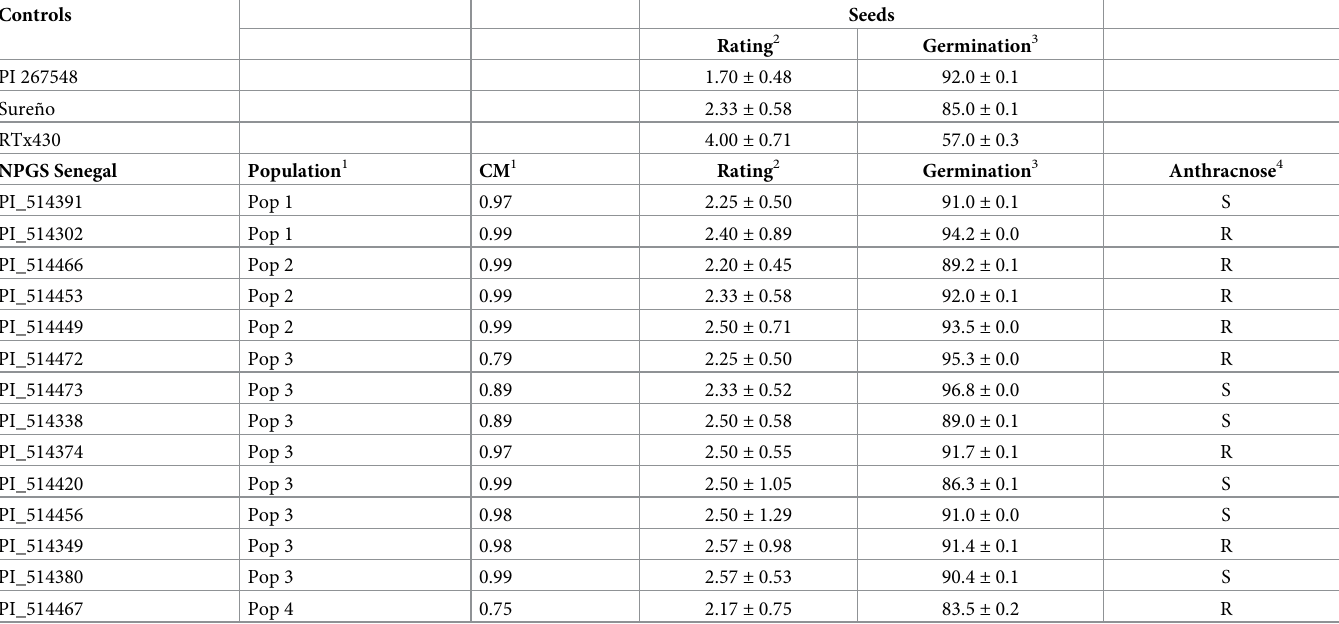
Table 4. Seed quality of NPGS Senegal sorghum accessions resistant to grain mold.